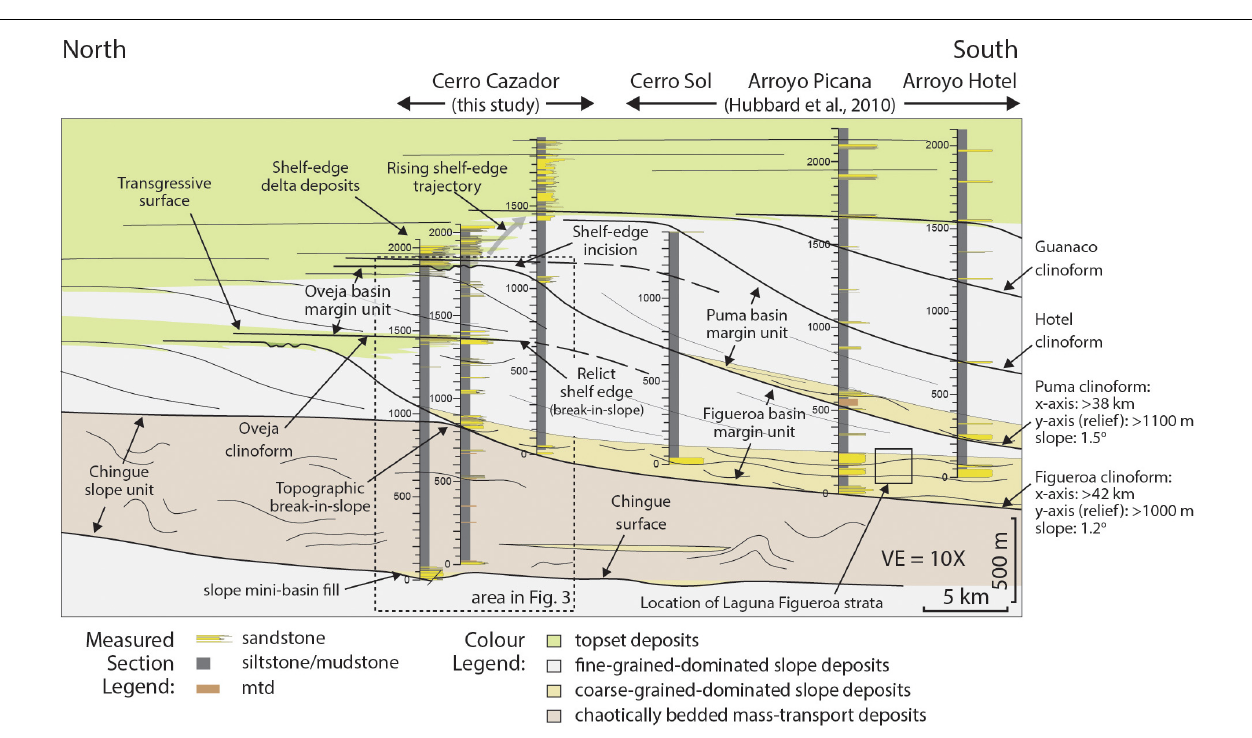
FIGURE 4 | Reconstructed dip-oriented regional cross-section of the Tres Pasos and Dorotea formations from Cerro Cazador to Arroyo Hotel, integrating data from this study, Hubbard et al. (2010), and Daniels et al. (2018) ( Figures 2E,F ). Note the presence of only two sandstone-prone stratigraphic intervals in the mudstone-dominated slope clinoform system, which immediately overlie the Figueroa and Puma clinoforms in the southern half of the